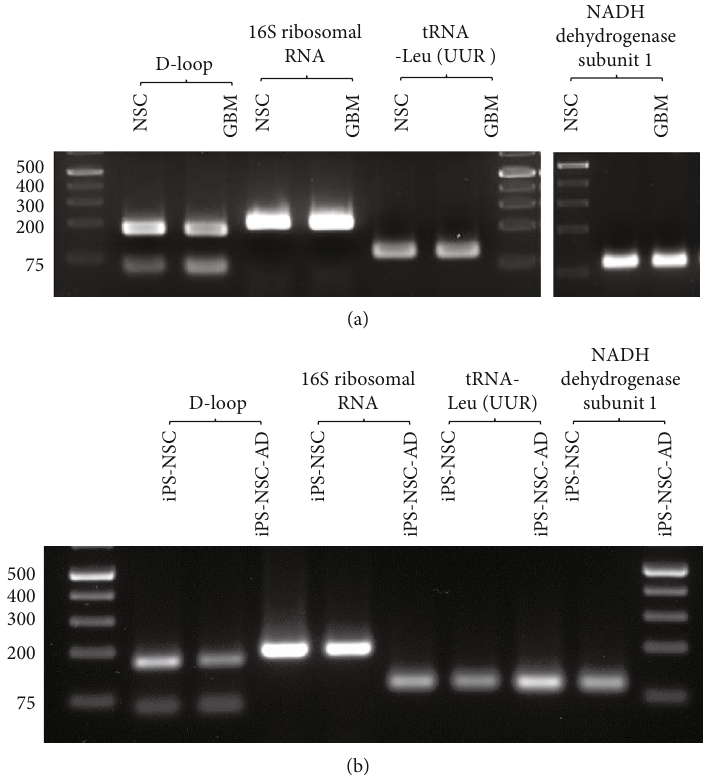
Figure 1: Typical gel images of exosomal mtDNA PCR products using primer sets described in Table 1. (a) NSC and GBM in the fi gure represent the mtDNA PCR products using exosomes isolated from neural stem cells (NSC) and glioblastoma multiforme (GBM) cell culture media as the sample. (b) iPS-NSC and iPS-NSC-AD in the fi gure represent the mtDNA PCR products using exosomes isolated from NSCs derived from iPS cells reprogrammed from B lymphocytes of control (iPS-NSC) and AD (iPS-NSC-AD)